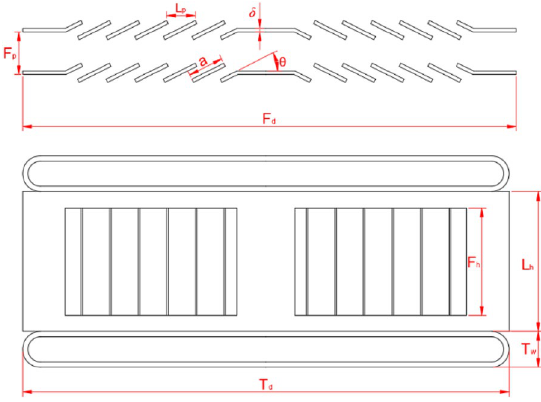
Figure 2 Schematic of structural parameters of the louvered fins